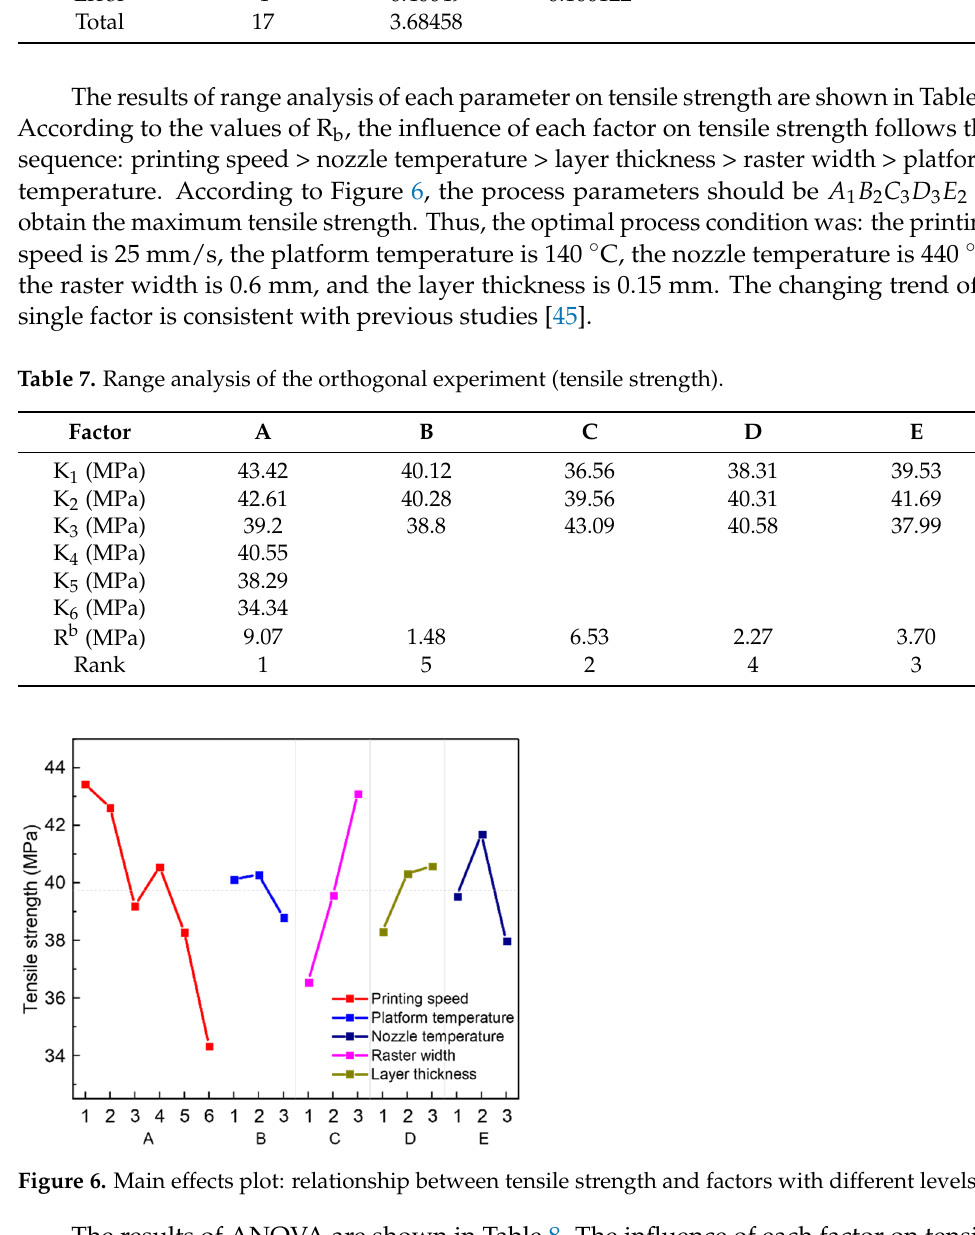
Table 8. Analysis of variance for the orthogonal experiment (tensile strength). Source